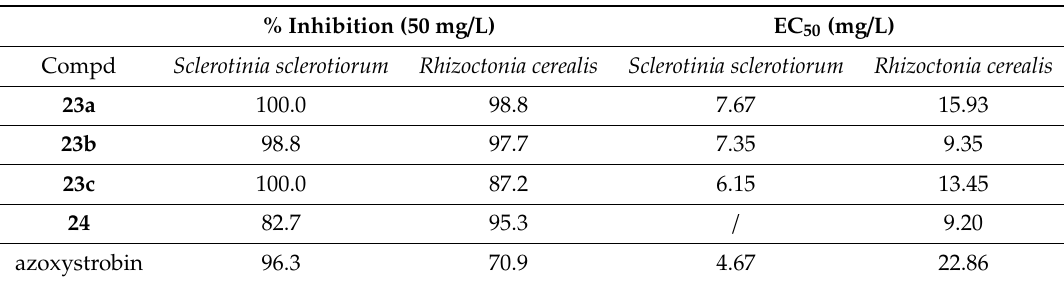
Table 3. Inhibition of fungal growth (%) of compounds 23a - c and 24 at 50 mg / L and EC 50 (mg / L) against Sclerotinia sclerotiorum and Rhizoctonia cerealis from Reference